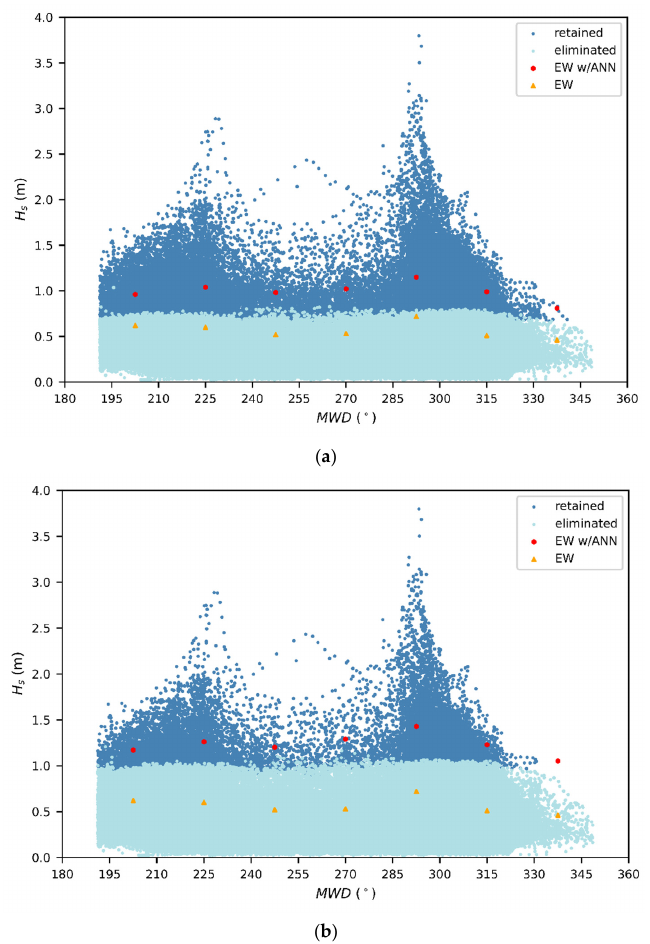
Figure 6. Retained (blue markers) and eliminated (light blue markers) sea-states by implementing the proposed methodology for the idealized case of bed slope 1:50 for ( a ) d 50 = 1 mm and ( b ) d 50 = 2 mm. The red data points denote the representatives for the simulation EW w/ANN and the orange those by implementing EW in the full dataset.